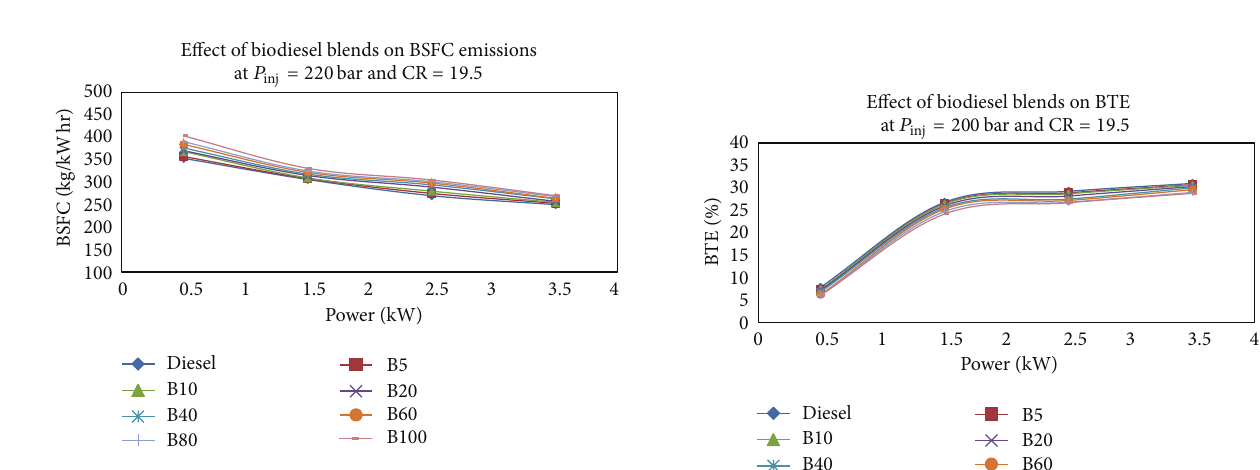
Figure 24: Variation in BSFC for various biodiesel blends at 𝑃 200 bar and CR 19.5.